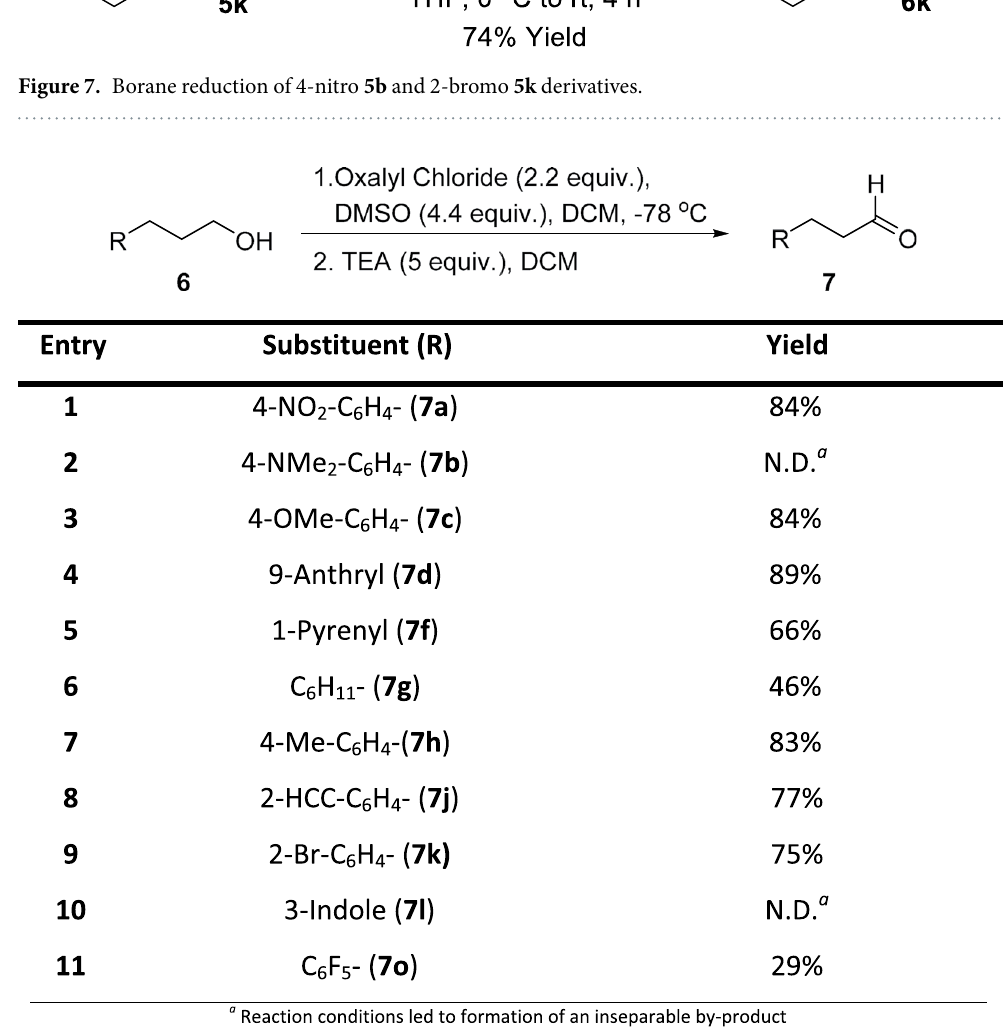
Figure 8. Swern oxidation of cinnamoyl alcohols to give corresponding hydrocinnamaldehyde